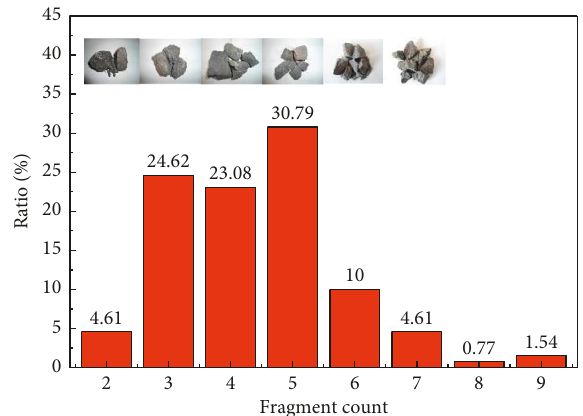
Figure 7: Ratio distribution of fragment